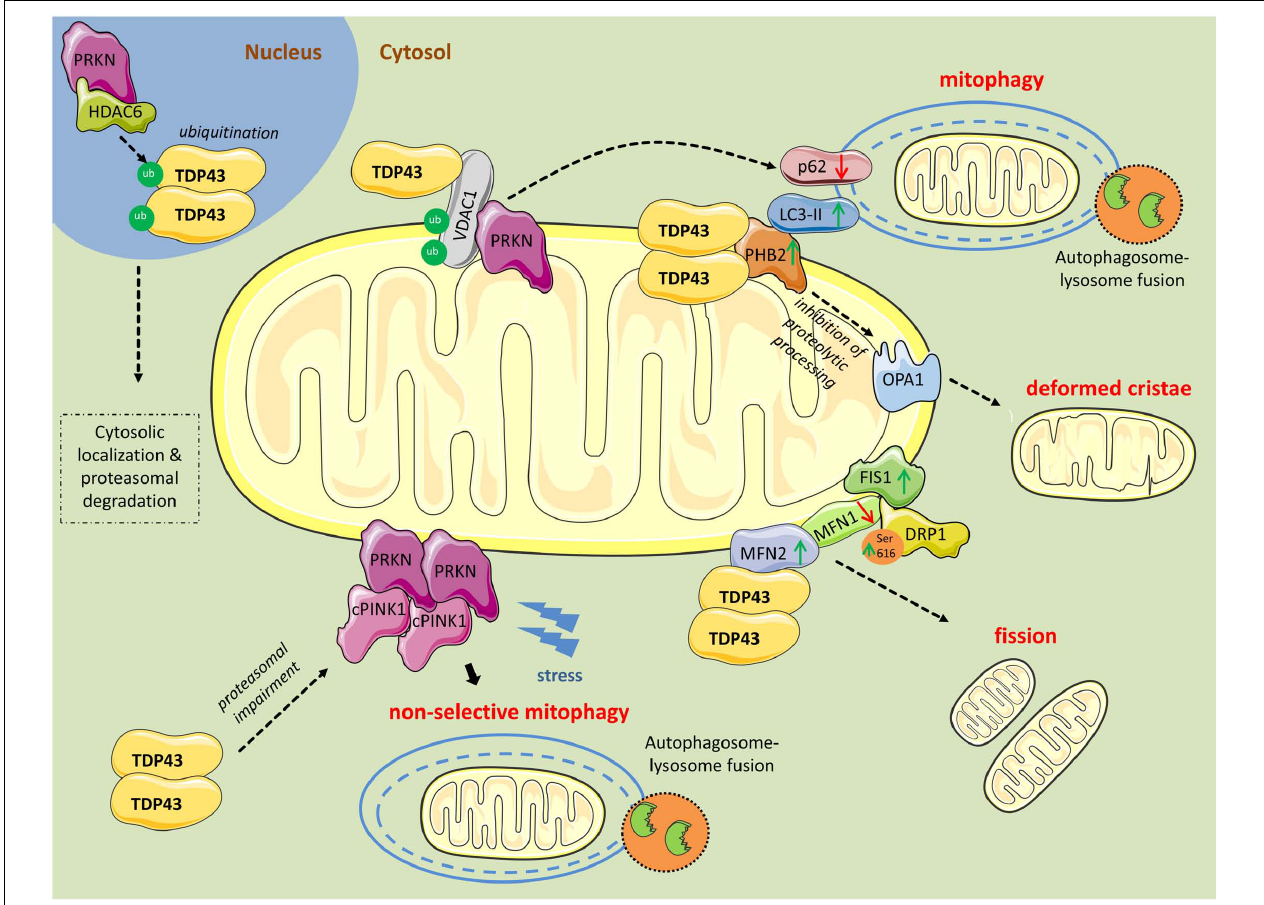
FIGURE 1 | Mitochondrial perturbations induced by TDP43. PRKN in complex with HDAC6, ubiquitinates nuclear TDP43 promoting its cytoplasmic localization and proteasomal degradation. However, as revealed from research in aging or neurodegenerative diseases, TDP43 often persists in the cytosol and forms aggregates. Excess cytosolic TDP43 interacts with VDAC1, located in the outer mitochondrial membrane, but it is still unclear if interferes with its functions. Polyubiquitination of VDAC1 by PRKN is essential for driving mitophagy. Moreover, cytosolic TDP43, translocated to the outer mitochondrial membrane, directly interacts with PHB2 and, in parallel, increases its protein levels. PHB2 is known to interact with LC3-II to induce mitophagy. PHB2 is also involved in mitochondrial membranes fusion by stabilizing indirectly the long forms of OPA1. Additionally, TDP43 directly interacts with MFN2, a mitochondrial membrane protein regulating mitochondrial fusion, and possibly stabilizes its expression. Concurrently, TDP43 leads to reduced levels of another fusion protein, MFN1, and increases levels of FIS1 and DRP1 phosphorylated at Ser616, proteins promoting mitochondrial fission. Finally, TDP43 downregulates PRKN mRNA and protein levels, and impairs the proteasome, leading to the accumulation of cleaved PINK1 (cPINK1) in the cytosol. During stress conditions cPINK1 aggregates recruit PRKN to the mitochondria launching mitophagy in otherwise healthy mitochondria (non-selective mitophagy).